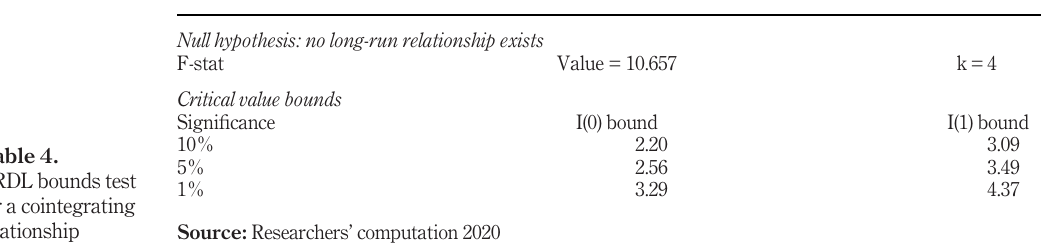
Dickey-Fuller (ADF) and Phillips-Perron